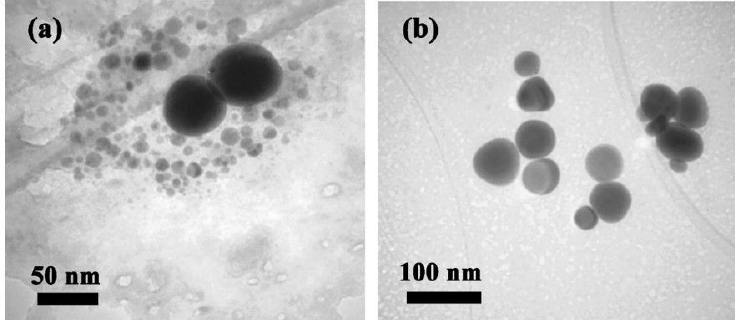
Figure 7. (a) TEM image of Fe-Co-V/Zeolite CNs and (b) TEM image of Fe-Co-Mo/Zeolite